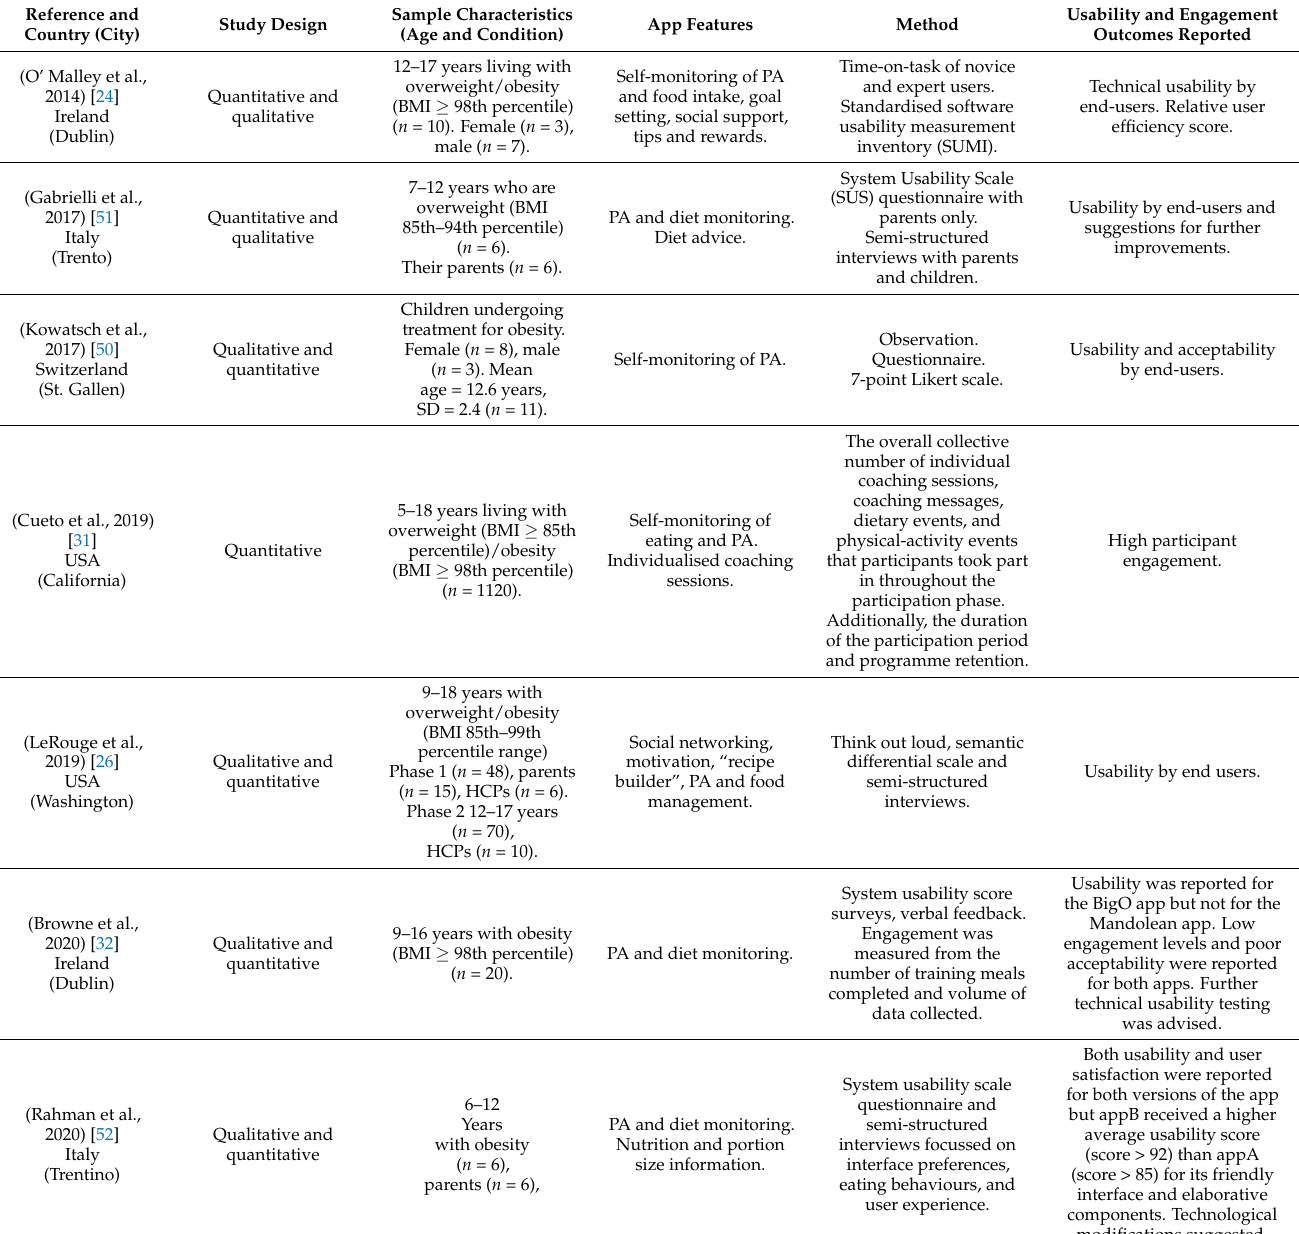
Table 2. Summary of studies testing usability and engagement of mHealth applications in children and adolescents with overweight/obesity ( n =